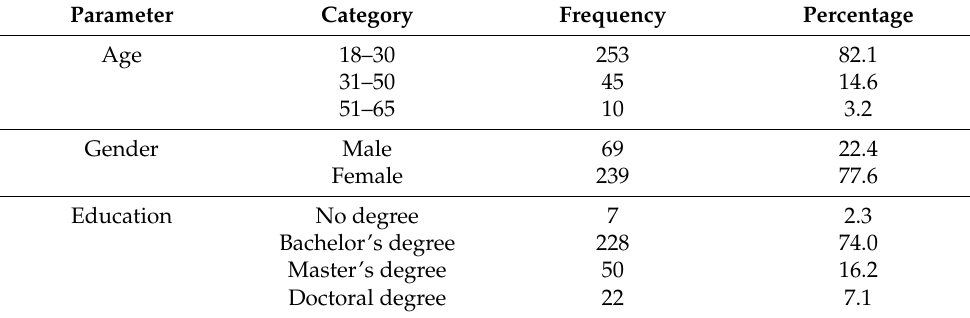
Table 1. Demographic characteristics of the participants (n =